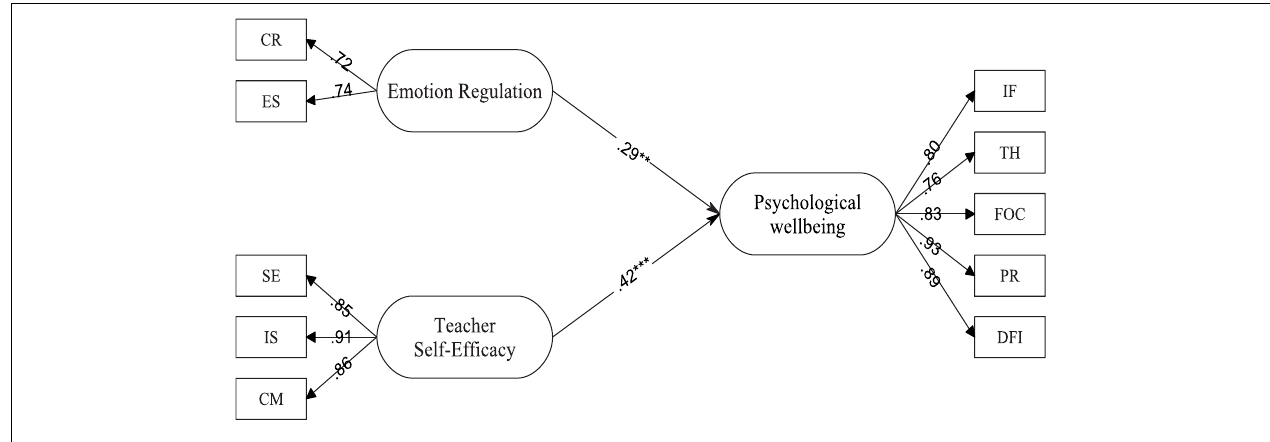
FIGURE 1 | The final model of teacher self-efficacy, emotion regulation, and teacher psychological wellbeing. * p < 0.05; ** p < 0.01; *** p < 0.001.